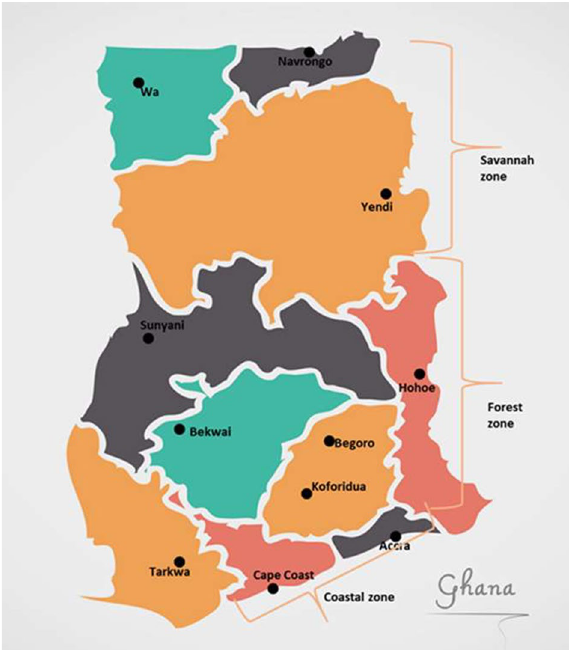
Figure 4. A map of Ghana showing the study sites in the ecological zones. These sites are designated for antimalarial drug therapeutic efficacy studies in all regions of